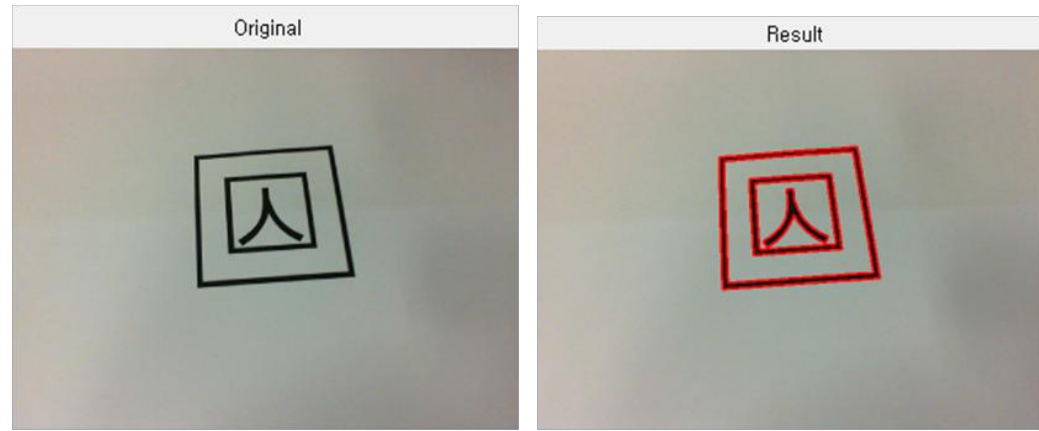
Figure 3. Marker detection using